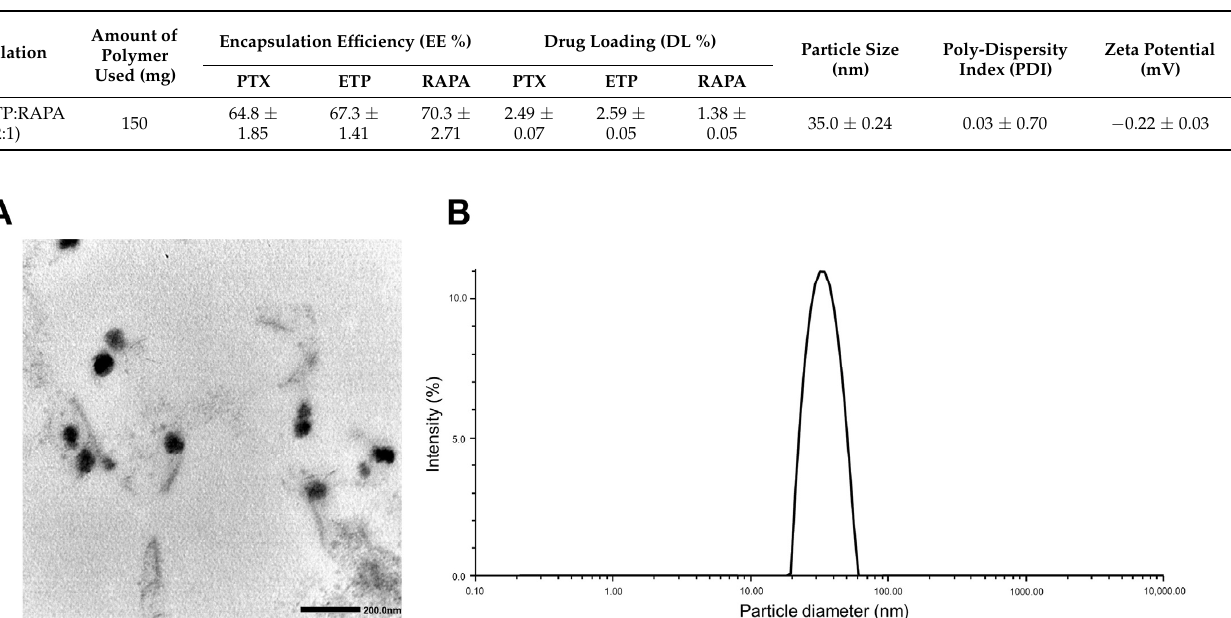
Table 1. Half-maximal inhibitory concentration (IC 50 ) and combination index (CI) values at two ra- tios of paclitaxel (PTX), etoposide (ETP), and rapamycin (RAPA) (n = 18).